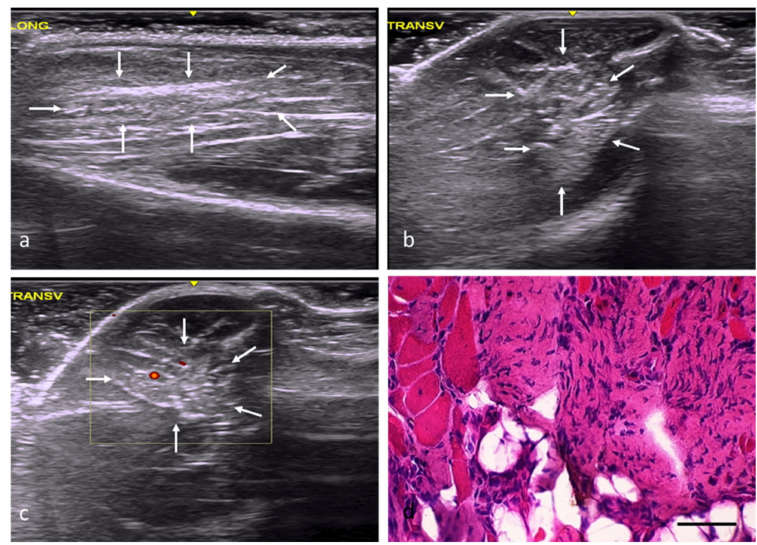
Figure 6. DM group. ( a ) Longitudinal axis, with images of an injury with increased echogenicity and a distorted echostructure compared with the adjacent muscle tissue. ( b ) Transverse axis, with images of a well-defined, oval injury with increased echogenicity. ( c ) Transverse section assessed by power Doppler imaging, with images of a slight, predominantly peripheral, increase in intralesional vascularization. ( d ) Transverse section representative of the muscle histology. H-E. Size scale: 100 µ m.